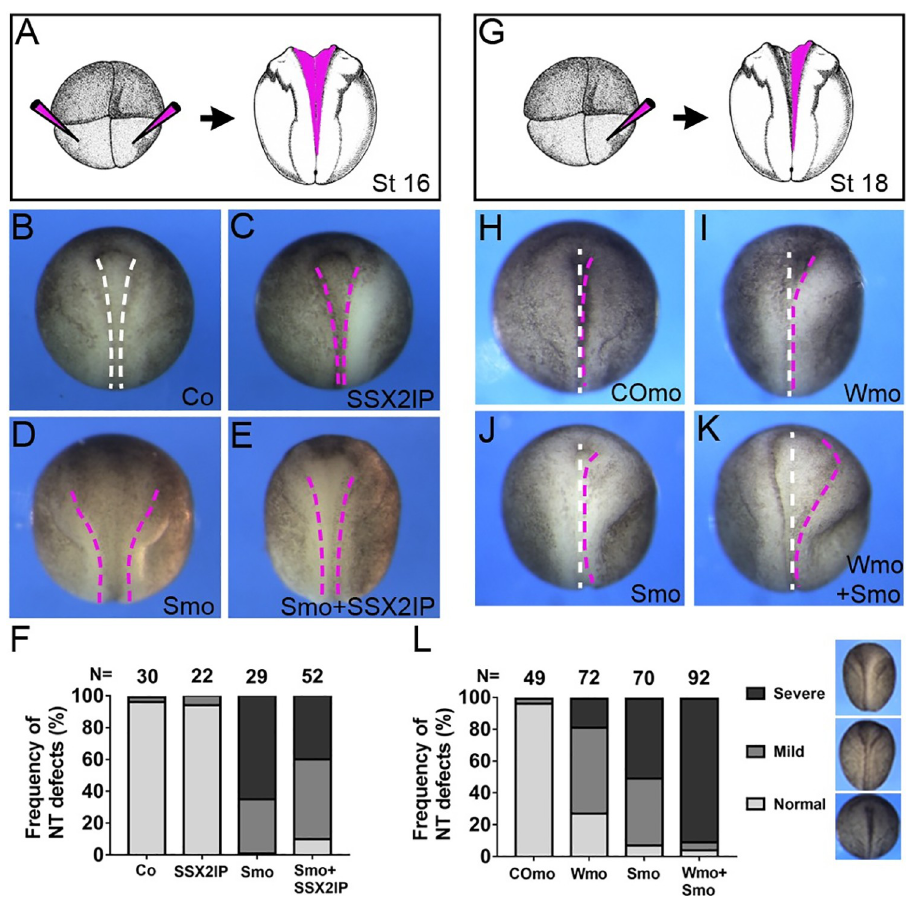
Fig 6. SSX2IP and Wtip functionally interact to promote neural tube closure. Embryos were injected bilaterally or unilaterally with 10 ng of Wtip MO (Wmo) or SSX2IP MO (Smo) or 20 pg of human SSX2IP RNA as indicated. Neural groove formation along the anteroposterior axis was assessed at stages 16–18. A-F, Neural tube closure defects in SSX2IP morphants. A, Scheme of the experiment. B-D, Dorsal views of representative embryos at stages 16–17, anterior is up. B, Control uninjected embryo, C, SSX2IP RNA injection. D, Embryo injected with Smo. E, Embryo injected with Smo and SSX2IP RNA. Human SSX2IP RNA partly rescues neural closure defects. Dashed lines indicate neural fold borders. F, Frequency of neural tube (NT) defects. Data are representative of two experiments. G-L, Functional interaction of SSX2IP and Wtip. G, Scheme of the experiment. H-L, Representative embryos at stages 18– 19 injected with control MO (CoMO, H), Wmo (I), Smo (J) or both Wmo and Smo (K). Midline, white dashed line, neural fold border, magenta dashed line. Anterior is up. L, Frequency of neural tube (NT) defects in the morphants. Data represent three different experiments. In F and L, total number of embryos per group is shown above each bar. Mild, severe and normal phenotypes have been scored separately, with examples shown in